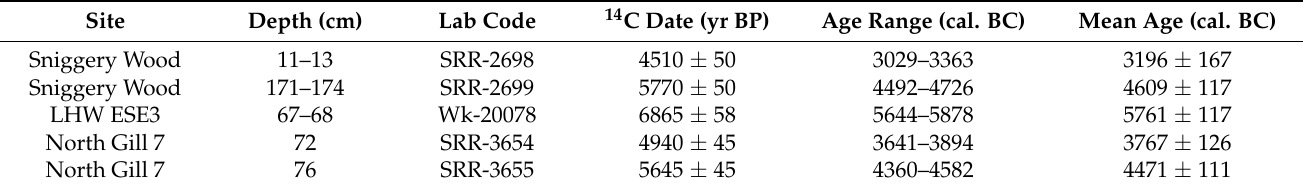
Table 1. Radiocarbon dating at Sniggery Wood, Little Hawes Water (LHW), North Gill 7 and Bonfield Gill